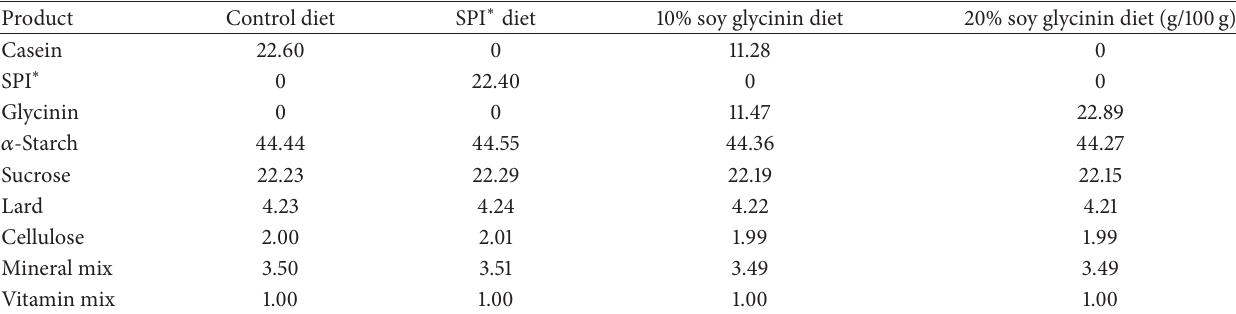
Table 1: Composition of the different experimental diets used in the present study.